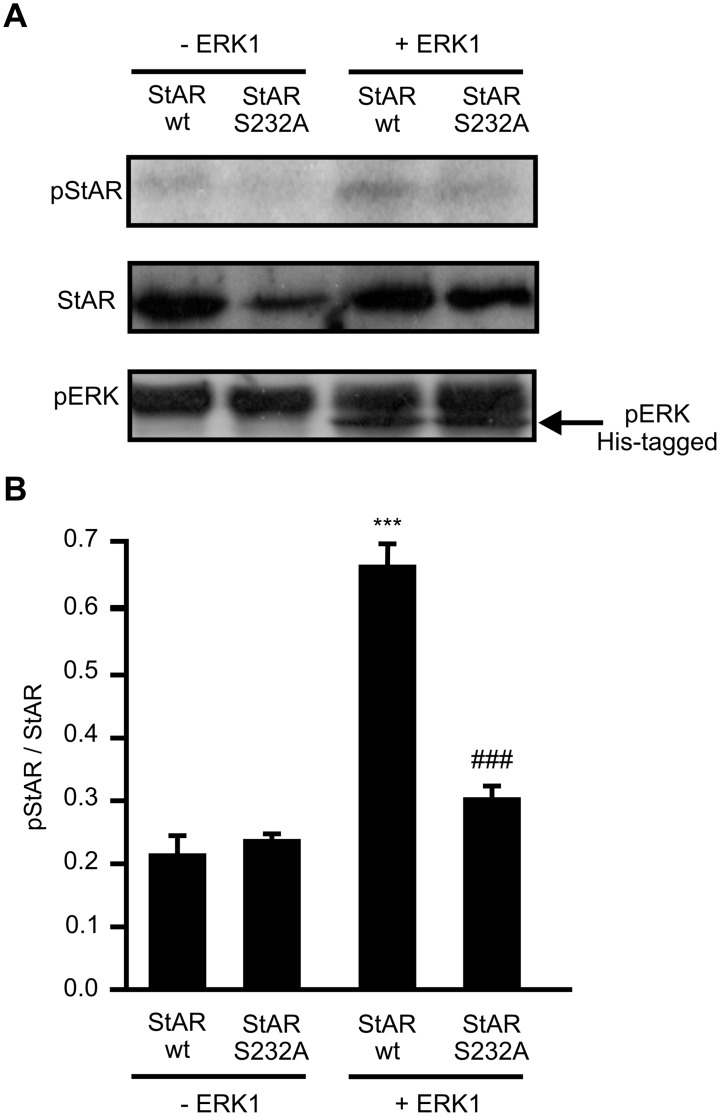
ERK phosphorylation of StAR in Ser232 drives StAR retention on the OMM.pRc/CMVi vector containing the StAR wt cDNA (StAR wt) or StAR mutant form (StAR S232A) were subjected to a transcription/translation import assay and in vitro phosphorylation (see Materials and Methods). Mitochondrial proteins were separated by SDS-PAGE, transfered to a PVDF membrane and then autoradiography and immunoblot were performed. A. Levels of phosphorylated StAR (pStAR) are shown in the presence or absence of active ERK1 (upper panel). The autoradiography displays a representative result of three independent experiments. The immunoblots (lower panels) show total mitochondrial StAR and phospho-ERK (pERK) levels. Representative western blots are shown. B. For each band, the OD of pStAR levels were quantified (arbitrary units) and normalized to the corresponding total StAR protein levels. The relative levels of pStAR are shown: ***p<0.001 vs. StAR wt without ERK1; ### p<0.001 vs. StAR wt with ERK1. Results are expressed as mean ± SEM of three independent experiments.